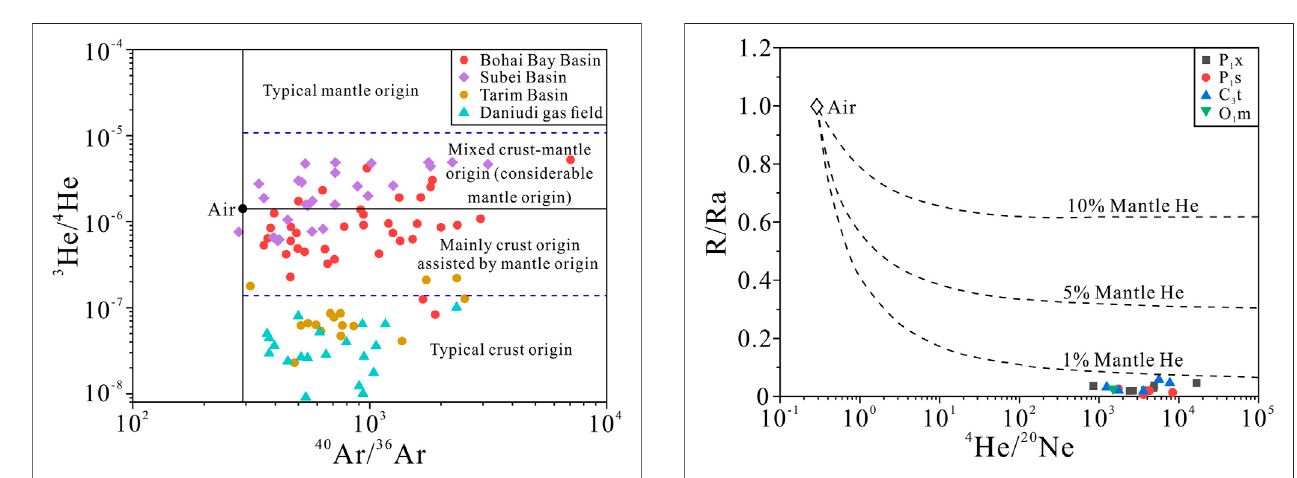
FIGURE 6 | Correlation of 3 He/ 4 He vs . 40 Ar/ 36 Ar of natural gas in the Daniudi gas fi eld and typical petroliferous basins in China [modi fi ed after Li et al . (2017)].